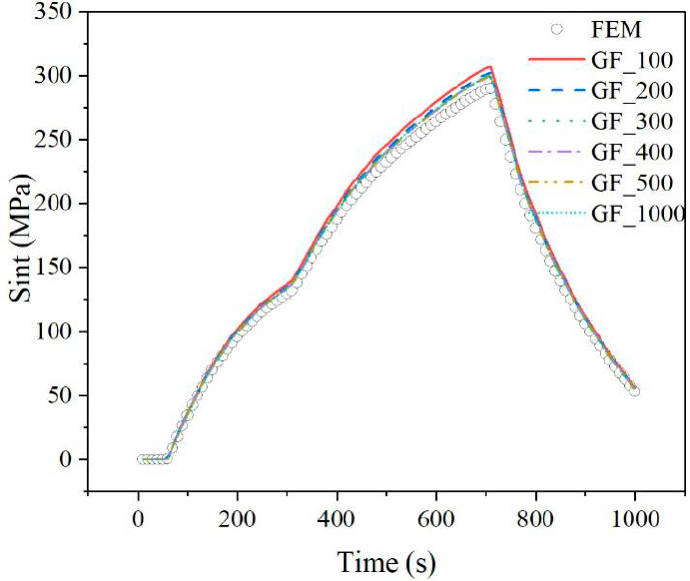
Figure 16. Comparison of Green’s function and finite element calculation results.